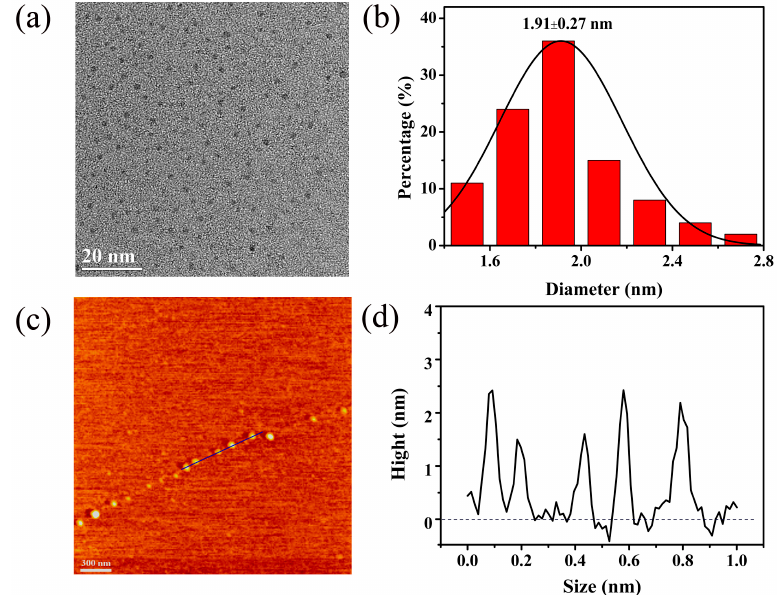
Figure 4. A typical HRTEM image ( a ) and particle size distribution histogram ( b ) of Pd NCs; AFM image of the Pd NCs ( c ) and its corresponding height profile ( d ).